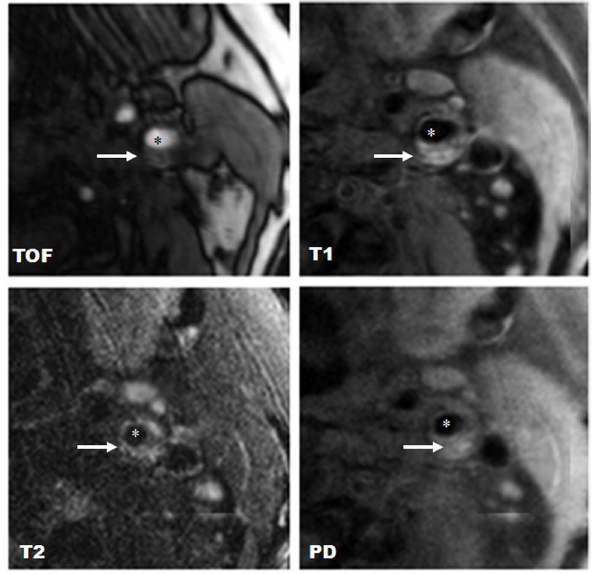
Figure 2. Example of lesion type VI in the left internal carotid artery. Lesion type VI is characterized by intraplaque hemorrhage; (*) indicates the lumen of the carotid artery; ( r ) indicates carotid plaque. Intraplaque hemorrhage shows high signal intensity on T1w, TOF,